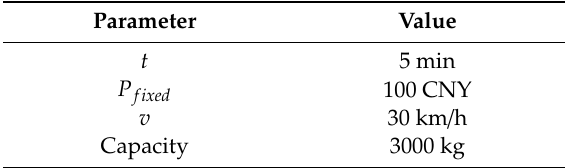
Table 10. Parameter